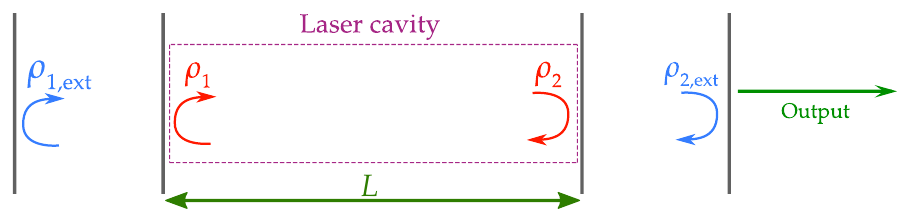
Figure 1. Schematic of a laser cavity affected by external optical feedback from both